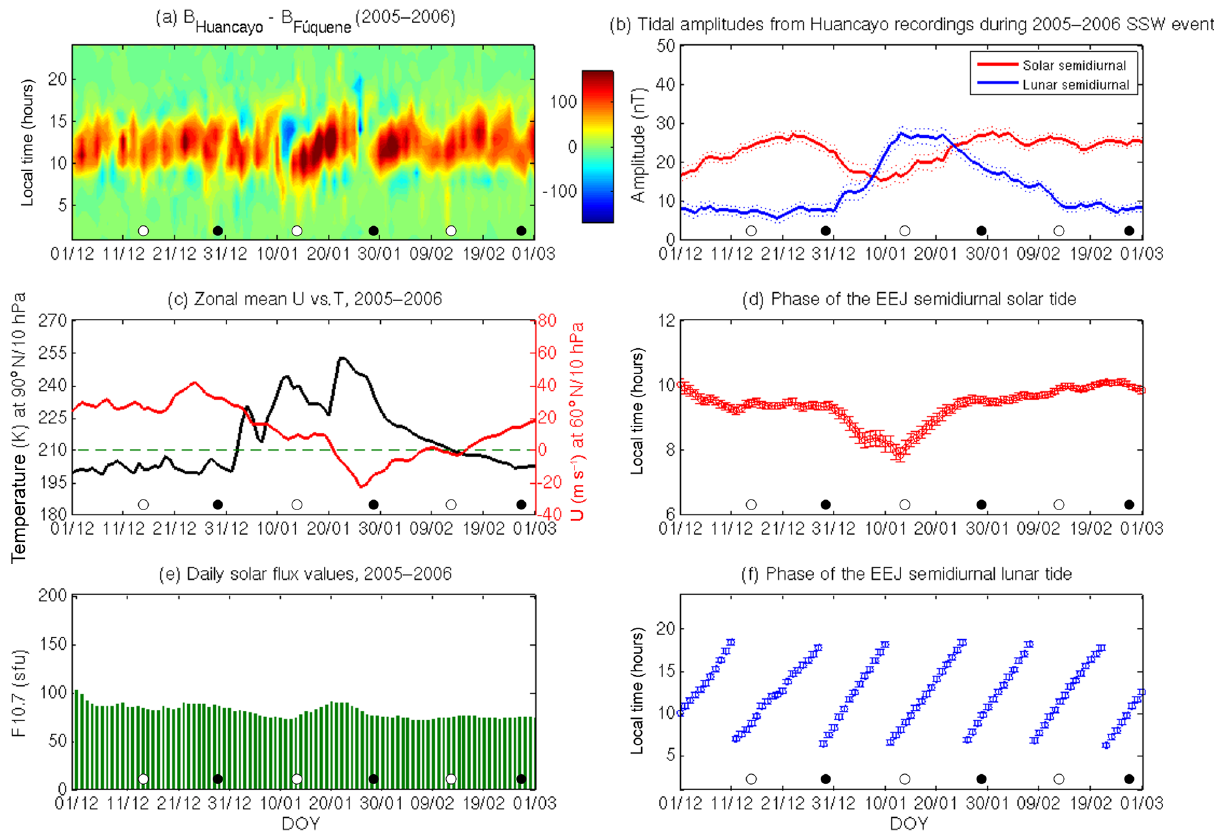
Figure 3. Same as Fig. 2, except between 1 December 2005 and 1 March 2006.